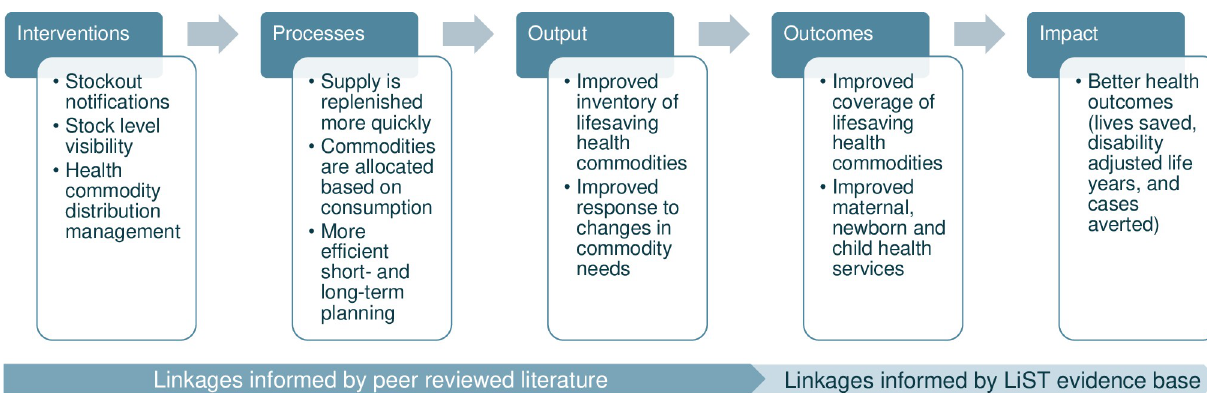
Fig 1. Impact model connecting digital health and improved health outcomes through LMIS. Abbreviations: LiST, Lives Saved Tool.